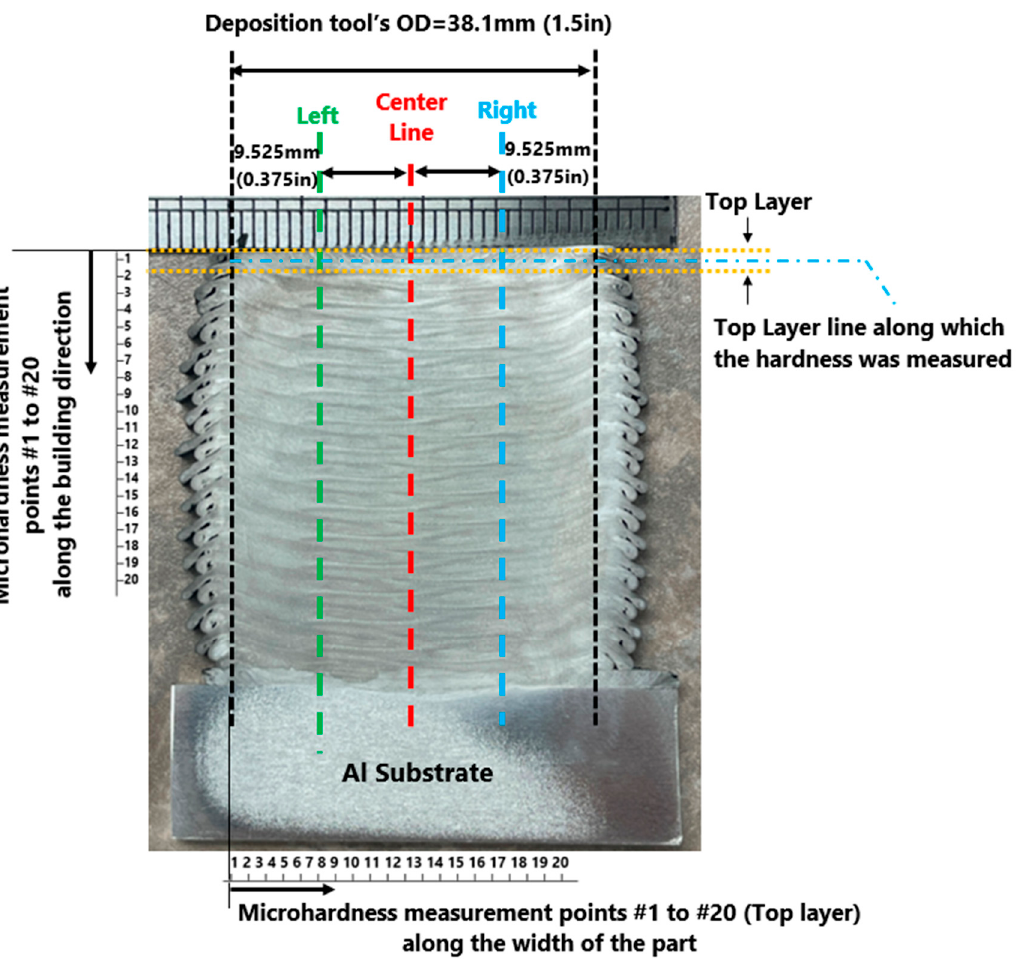
Figure 4. Microhardness measurement points along the building direction for the inner layers and along the as-deposited parts’ cross-section’s width for the top layer.